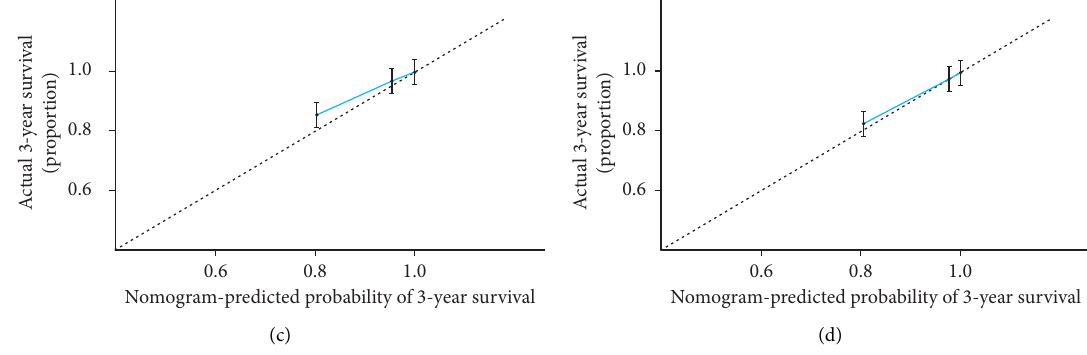
Figure 4: 3-year (a) and 5-year (b) overall survival nomogram internal verification curves and 3-year (c) and 5-year (d) cancer-specific survival nomogram internal verification